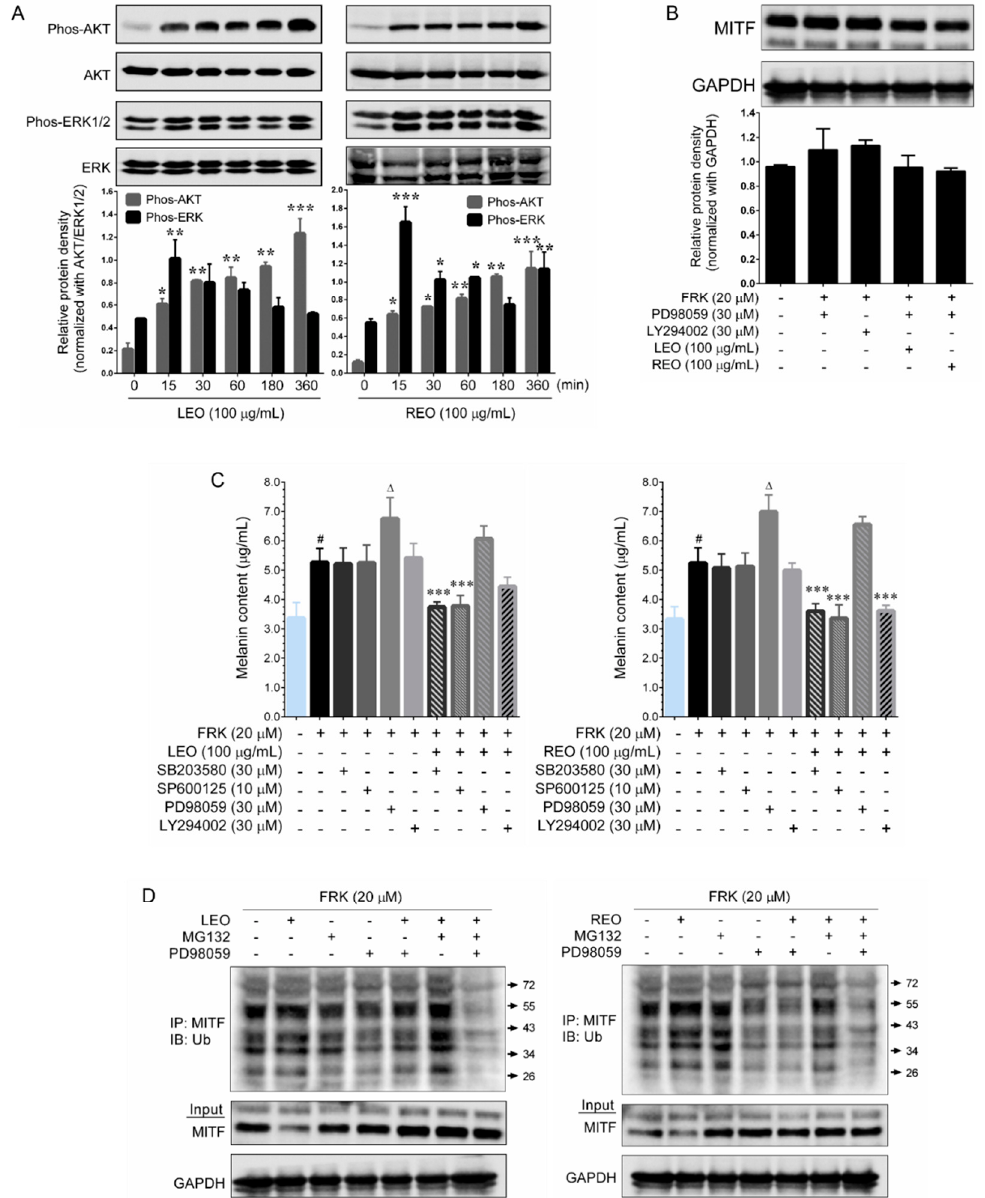
Figure 3. E ff ect of LEO and REO on ERK1 / 2 and AKT activation. ( A ) B16-F10 cells were treated with LEO or REO for 15 min to 6 h. The phosphorylation of ERK1 / 2 and AKT were determined by western blot analysis using specific antibodies. Histogram shows the relative protein expression of phos-ERK1 / 2 and phos-AKT levels, which are normalized with total levels of corresponding proteins. ( B ) The e ff ect of LEO and REO on MITF protein expression under pharmacological inhibition of ERK1 / 2 and AKT were determined by western blot analysis. ( C ) E ff ect of LEO and REO on FRK-induced melanin content was determined after pre-treated with p38 MAPK, ERK1 / 2, JNK / SAPK and AKT inhibitors for 2 h. ( D ) Ubiquitination of MITF was determined in B16-F10 cells treated with LEO or REO with ERK1 / 2 and proteasome inhibitors for 6 h. The cells were immunoprecipitated using an anti-MITF antibody and immunoblotted using an anti-ubiquitin antibody. Data represent the mean ± SD of three experiments. Statistical significance was set at # p < 0.05 compared to control vs. FRK, ∆ p < 0.05 compared to FRK vs. ERK1 / 2 inhibitor (PD98059) and * p < 0.05, ** p < 0.01, *** p < 0.001 compared with FRK + sample treatment groups vs. control group.